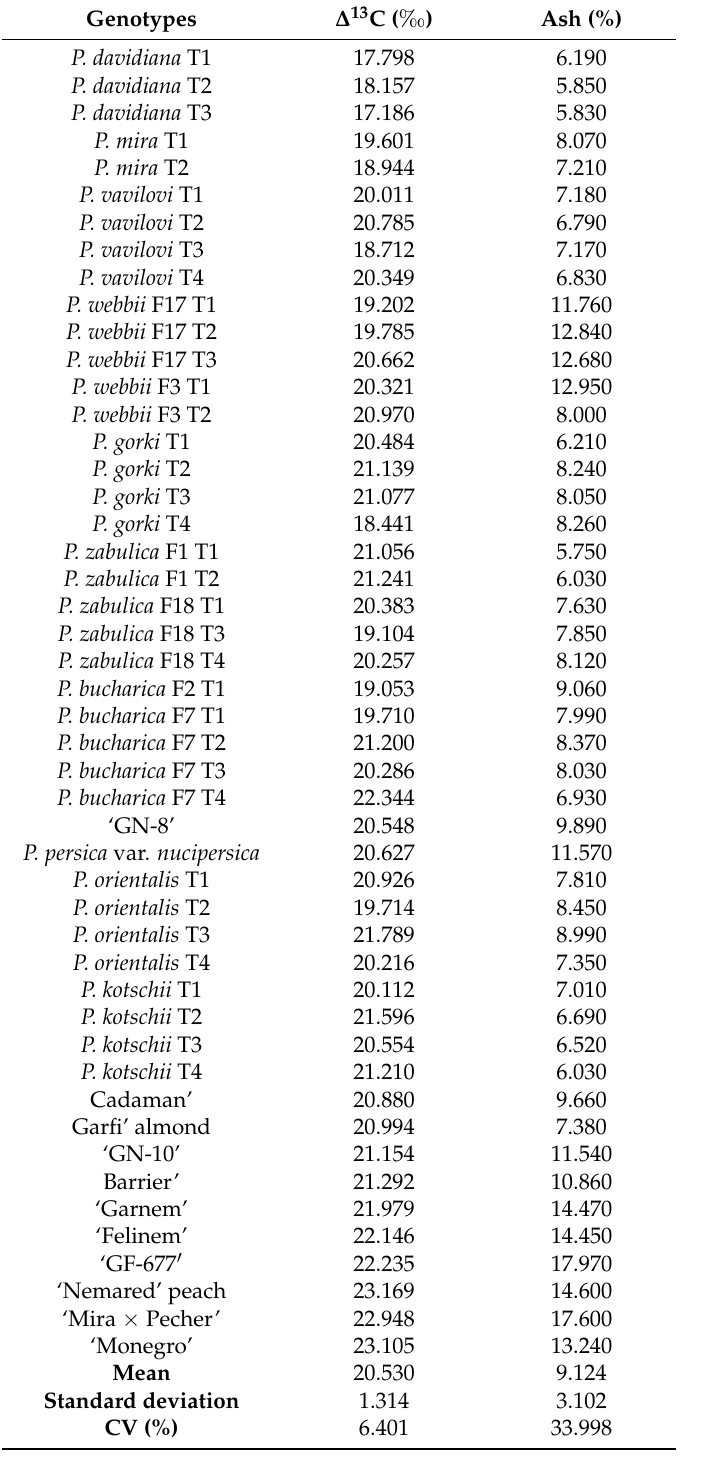
Table 1. Carbon isotope discrimination [ ∆ 13 C ( ‰ )] and leaf ash content (%) of 21 Prunus genotypes. (SD: Standard Deviation; nd: no data; CV: Coefficient of